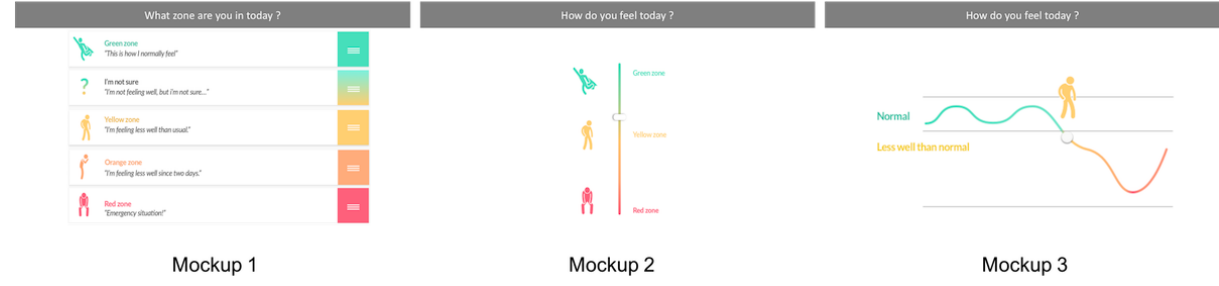
Figure 3. Low-fidelity paper prototypes of 3 scenarios to determine symptoms